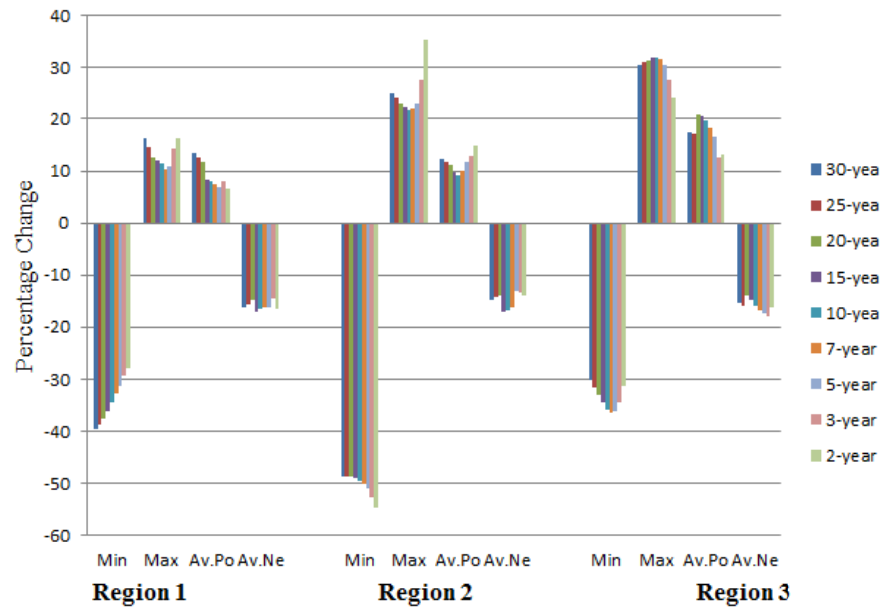
Figure 3. Percentage change in heavy rainfall for each region with the maximum (max), the minimum (min) and the averages of positive (Av.Po) and negative (Av.Ne) changes for different return periods.